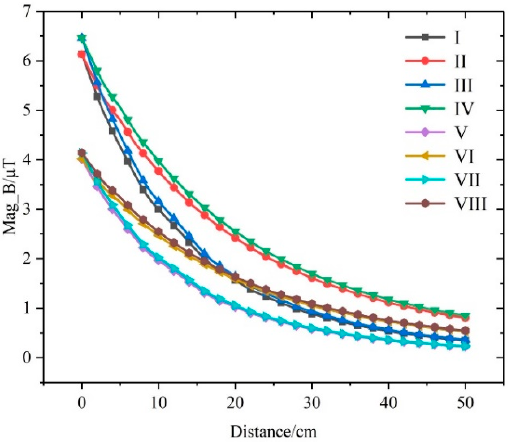
Figure 11. The trends of the B-field strength along two lines in four cases.